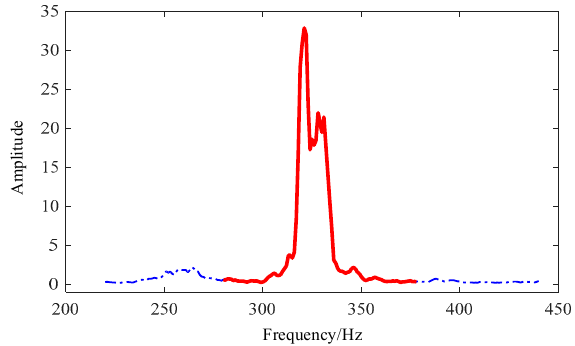
Figure 2. Isolated tonal lobe (solid line).